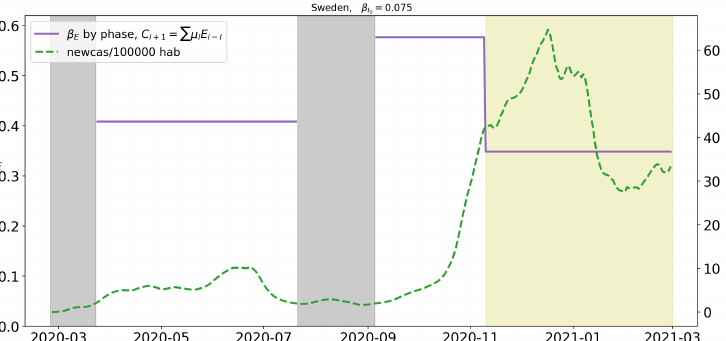
Figure 6. Value of β E for the different levels of lockdown. Yellow background corresponds to a mild social distancing measure classified as Stage 3 and white background to “normality”, with no substantial self-isolation measures adopted. A green dotted line corresponds to the value of new cases per 100,000 hab.